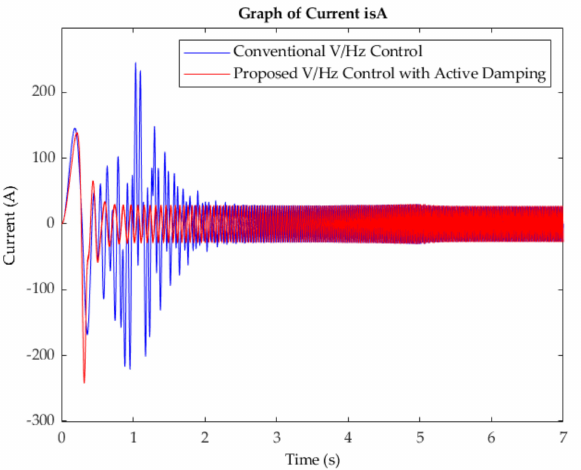
Figure 14. Stator phase A current i sA —active damping technique (red) vs. conventional V/Hz (blue).